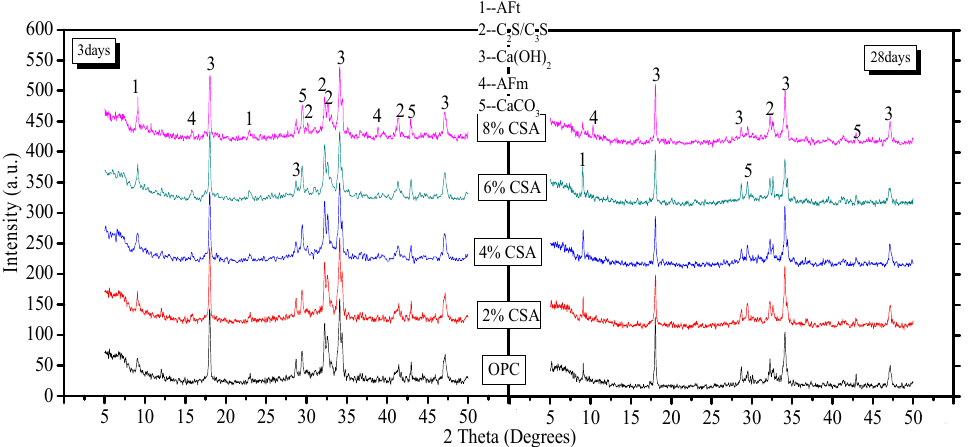
Figure 5. XRD patterns of OPC paste with and without CSA